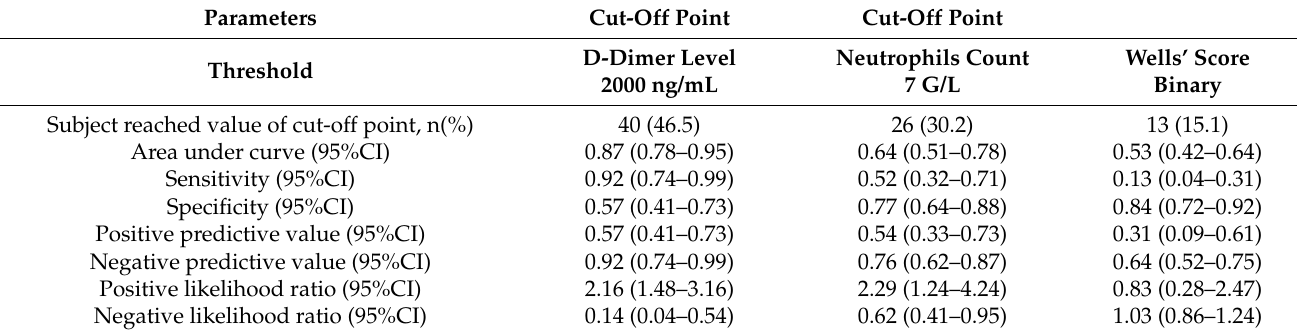
Table 4. Test characteristics of biomarkers identified in multivariate regression model for predicting the PE diagnosis and of Wells’